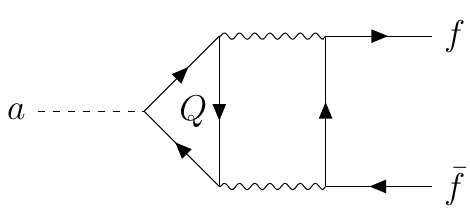
Figure 6 . ALP coupling to SM fermions in a KSVZ-like scenario, where Q are the heavy fermions carrying PQ